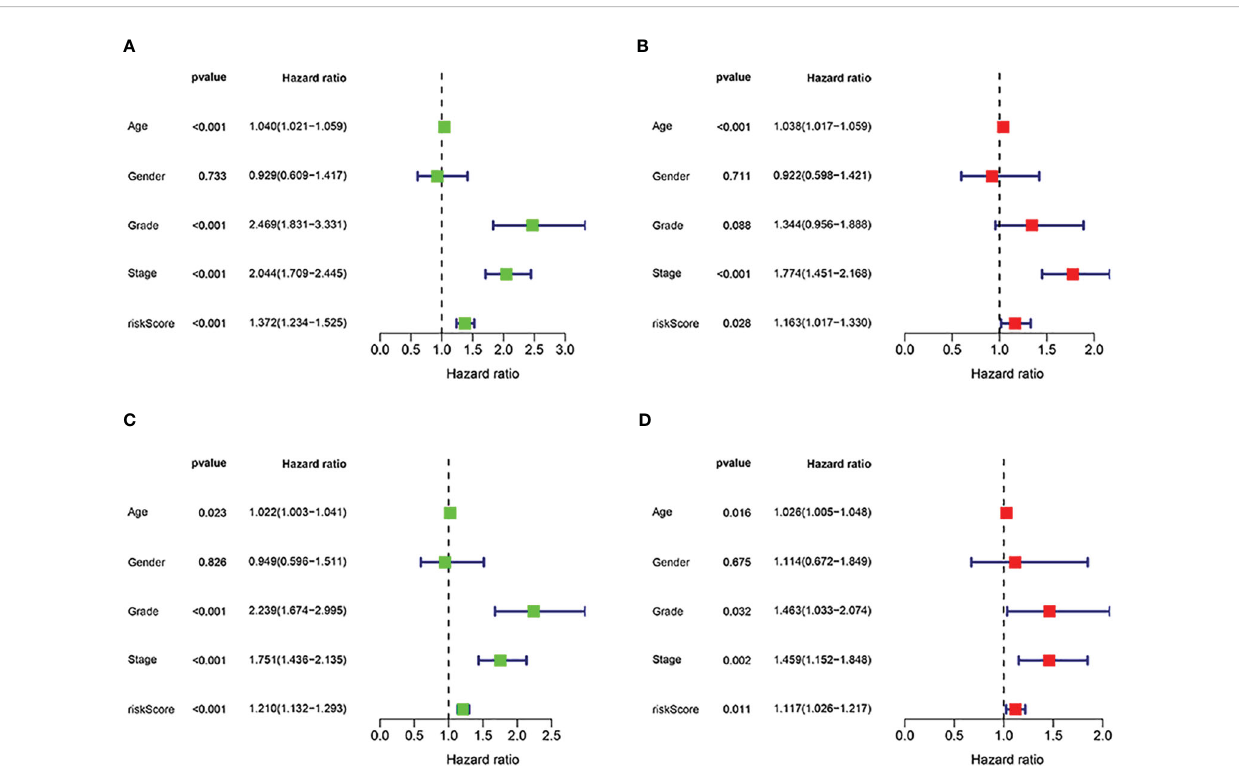
FIGURE 5 Independent prognostic analysis of the signature. (A, B) Cox regression revealed that the risk score was an independent prognostic factor in ccRCC patients in training group. (C, D) Cox regression revealed that the risk score was an independent prognostic factor in ccRCC patients in validation